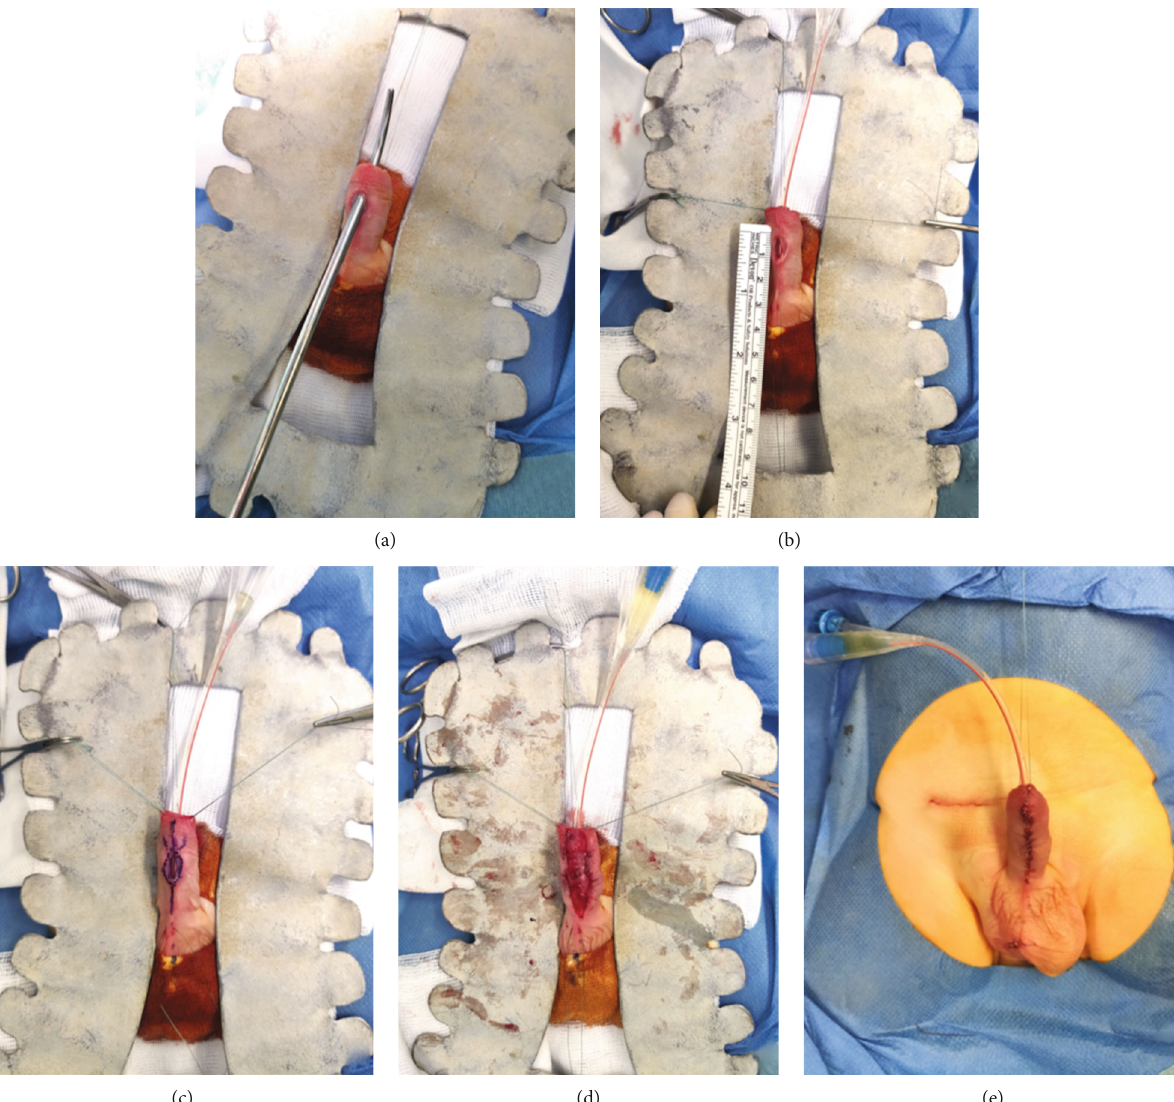
Figure 3: Surgical correction at the age of 6 months. Permeability of the distal urethra is tested with a urethral dilator until 12 Fr (a). An 8 Fr Foley catheter is inserted, and the congenital urethral fi stula is measured (b). Drawing of skin incision (c). Primary fi stula closure is performed by the tubularization technique, and spongioplasty is done to cover the urethroplasty (d). Final postoperative result